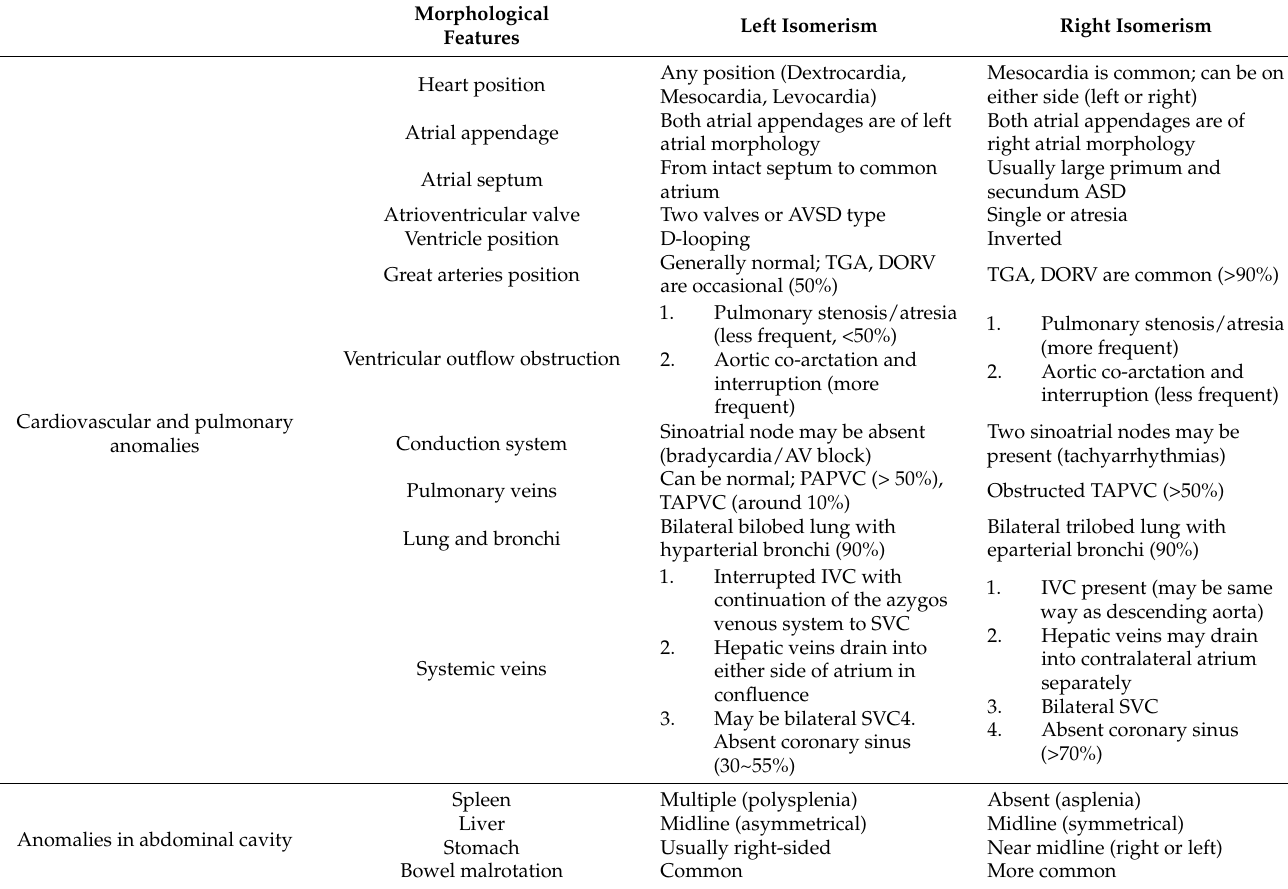
Table 2. Comparison of cardiac and extracardiac presentation in heterotaxy